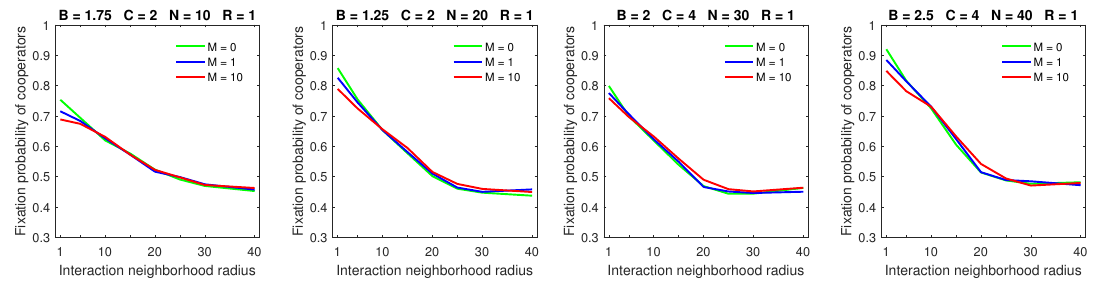
Figure 4. Increasing the mobility rate has no effect on the fixation probability of cooperators in the deterministic dispersal model when the dispersal range is small except for very small interaction neighborhoods.